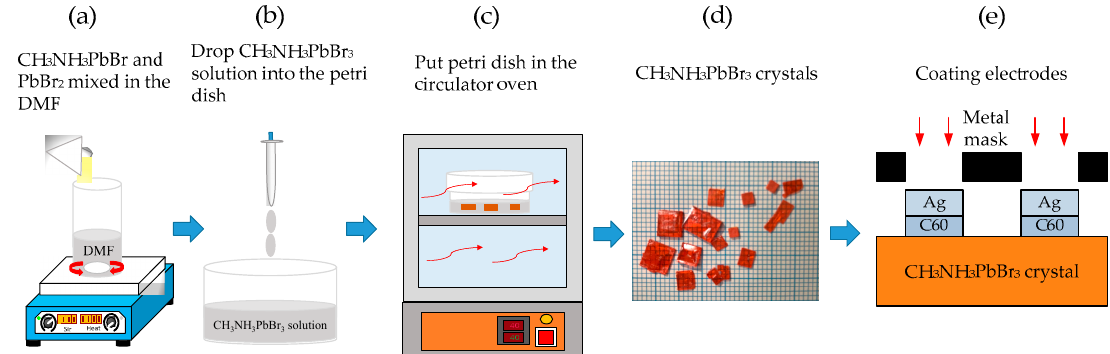
Figure 1. Schematic diagram of experimental procedure in this research.